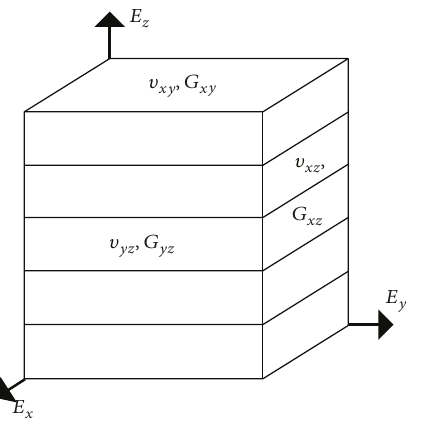
Figure 2: Rock mechanical parameters in shale (Figure 1(b)), u i is the pure imaginary number, and μ the positive root of